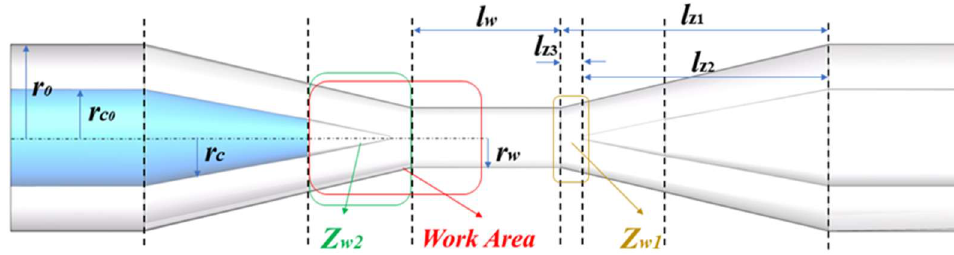
Figure 2. Annotation diagrams of OM-related parameters used in the calculations of this section.